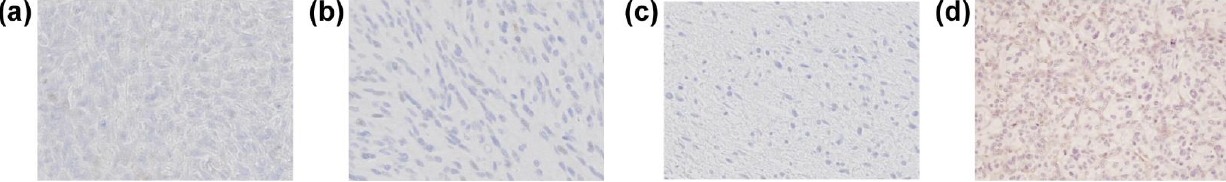
Figure 4. Differential diagnoses stained with SSTR2; ( a ) solitary fibrous tumor; ( b ) schwannoma; ( c ) neurofibroma; ( d ) hemangioblastoma (×20). Table 5. Association between SSTRs expression and overall survival (OS) or recurrence (TTR) from univariate Cox regression analyses. Significant results marked in bold.